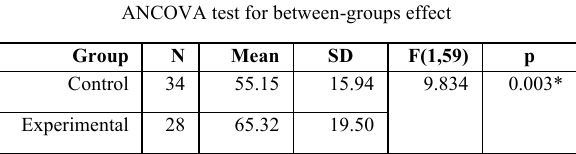
TABLE II. T HE RESULT OF THE STATISTICAL TEST FOR THE FINAL EXAM SCORES COMPARISON